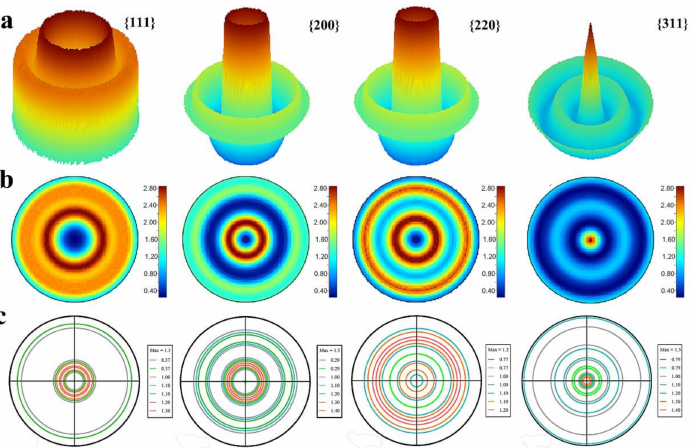
Figure 2. ( a ) The simulated 3D pole figure with the exponential harmonics method in MAUD. ( b ) The simulated 2D pole figure with the exponential harmonics method in MAUD. ( c ) The constructed completed pole figure with the traditional incomplete pole figure measurements with